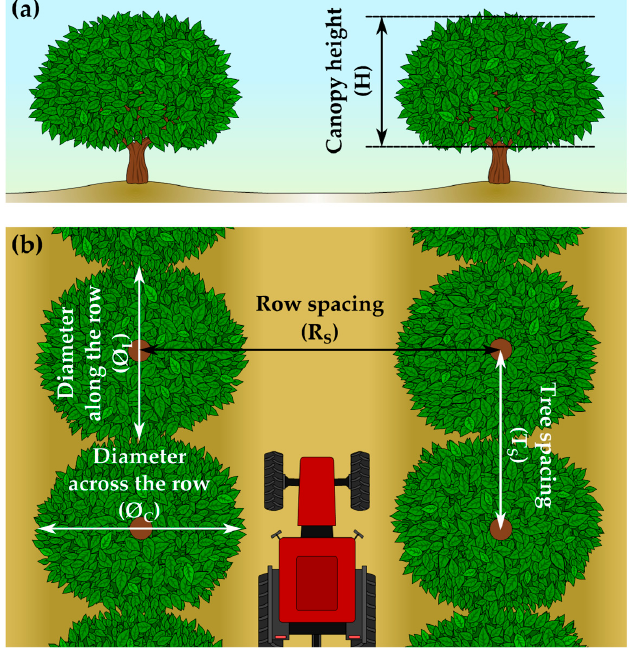
Figure 3. Canopy dimensions: ( a ) side view across the row of a standard citrus trees and ( b ) top view of a citrus orchard.